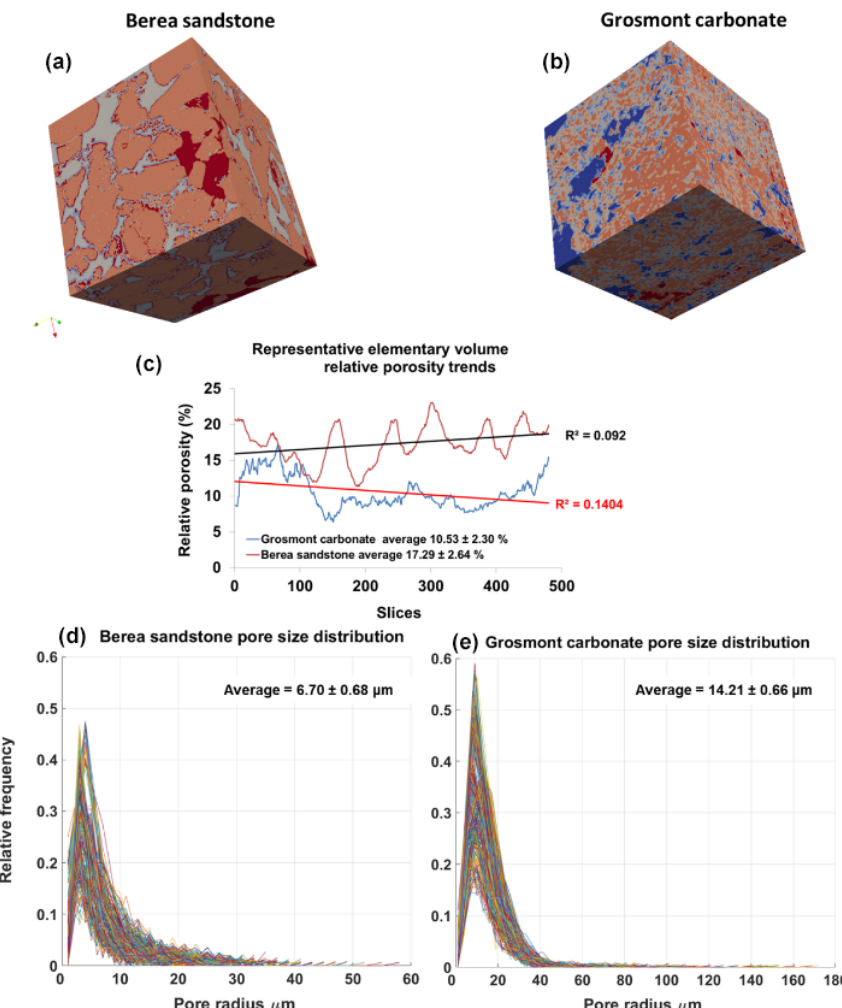
Figure 6. Panels (a, b) show surface plot of REVs of Berea sandstone and Grosmont carbonate (size 471 × 478 × 480) using the visu- alization ParaView software. Panel (c) shows the relative porosity (%) trend for Berea sandstone and Grosmont carbonate REV samples. Panels (d, e) show the pore size distribution of Berea sandstone and Grosmont carbonate. XCT images were segmented using k means. In the case of Grosmont, a non-local means filter was